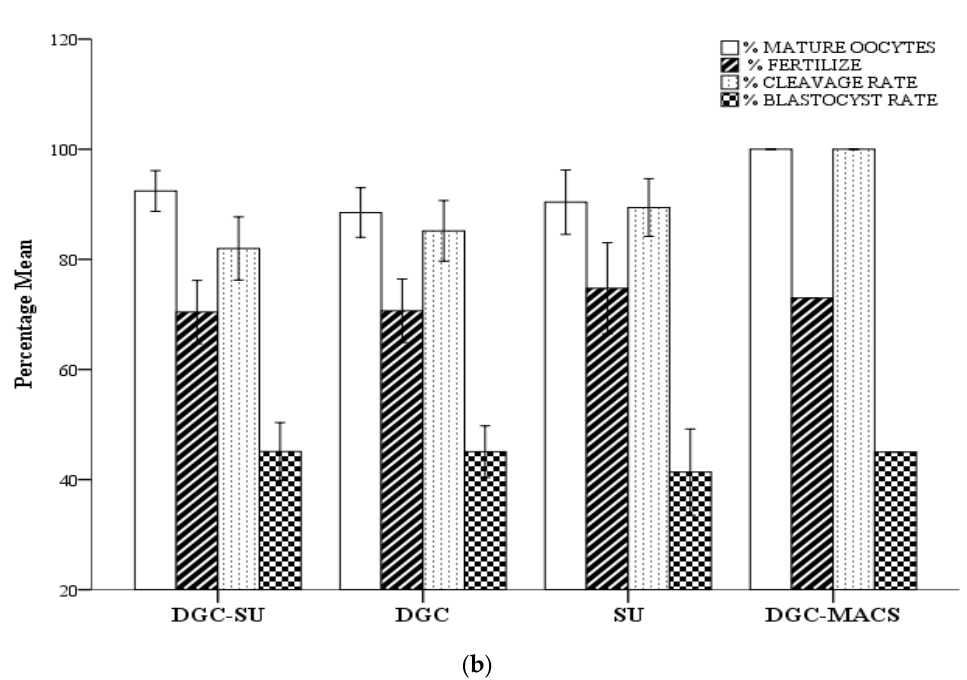
Figure 2. Effect of different semen preparation methods on assisted conception outcomes. ( a ) Number of MIIs (mature oocytes), number of day three embryos, number of grade one embryos and number of embryos transferred; ( b ) percentage of mature oocytes, fertilization rate, cleavage rate and blastocyst rate. Table 5. MII (oocyte metaphase two), 2PN (two pronuclei), fertilization rate, D3 EMB (day three em- bryo), cleavage rate and number (N) of embryos transferred in the four processing group populations with < 20 and ≥ 20% SDF in each studied